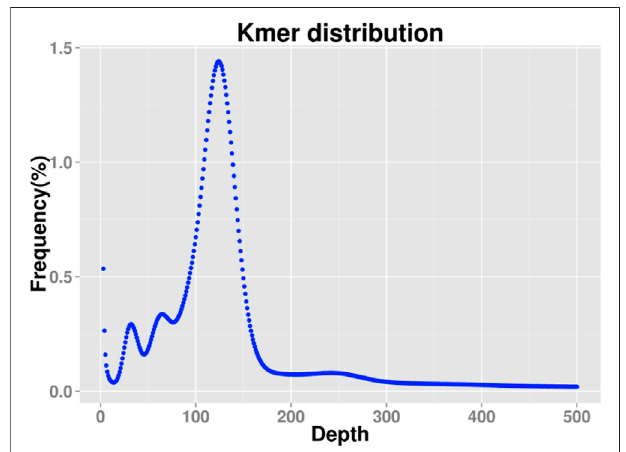
FIGURE 2 | 19 K-mer analysis for estimating the genome size of Schizothorax